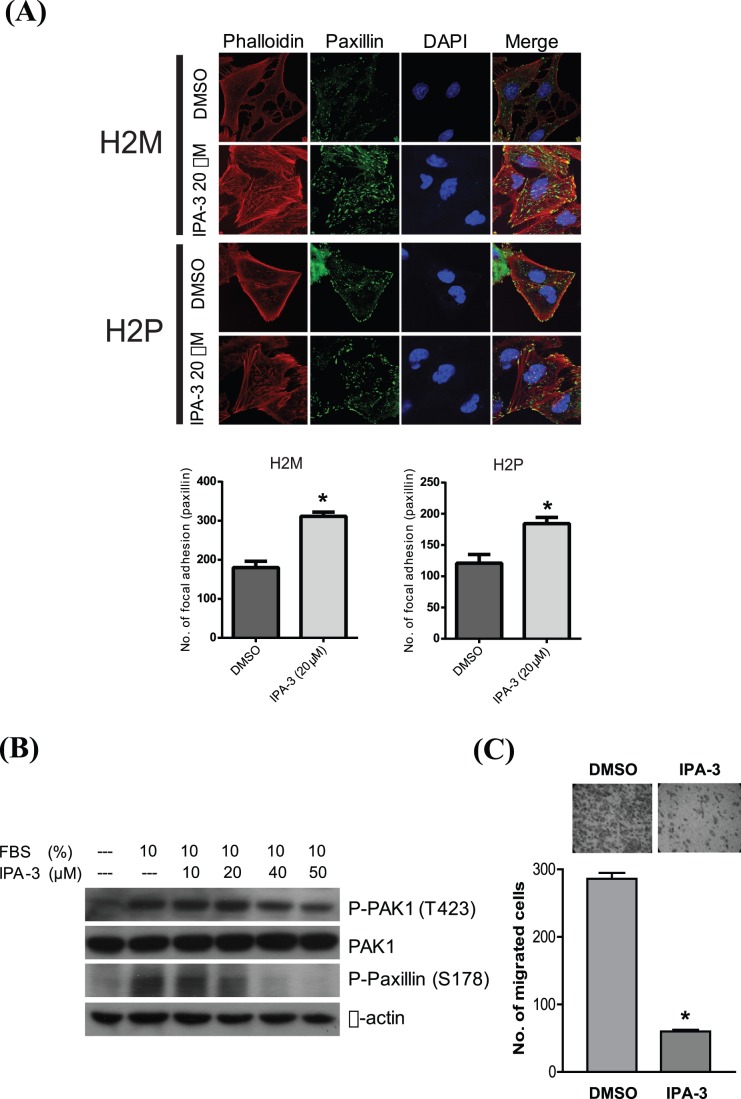
The suppressive effect of IPA-3 on migration of H2M cells.(A) Paxillin protein expression was detected by immunofluorescence analysis under IPA-3 treatment. H2M and H2P (upper panel) cells were serum-starved overnight and treated with either DMSO control or IPA-3 (20 µM) for 15 minutes, followed by FBS replenishment for 10 minutes. Immunofluoresence signals of phalloidin (Red), paxillin (Green) and DAPI (Blue) represent stress fiber, focal adhesion and nucleus, respectively (magnification 40X). The number of focal adhesion (paxillin) were counted in H2M (lower, left panel) and H2P (lower, right panel), and represented in the bar chart. Error bars, mean ± SD of triplicate samples. *P<0.01 (t-test) compared with DMSO control. (B) Western blotting analysis on the phosphorylation levels of PAK1 and paxillin. Serum-starved cells were treated with various concentrations of IPA-3 as indicated for 15 minutes, followed by FBS replenishment for 10 minutes. (C) Representative images of Transwell migration assay of H2M cells. Cells were treated with either DMSO or 10 µM IPA-3, and were allowed to migrate for 24 hours. Images show the cells having migrated to the lower chamber (upper panel). The number of migrated cells were counted and represented in the bar chart (lower panel). Error bars, mean ± SD of triplicate samples. *P<0.01 (t-test) compared with DMSO control.